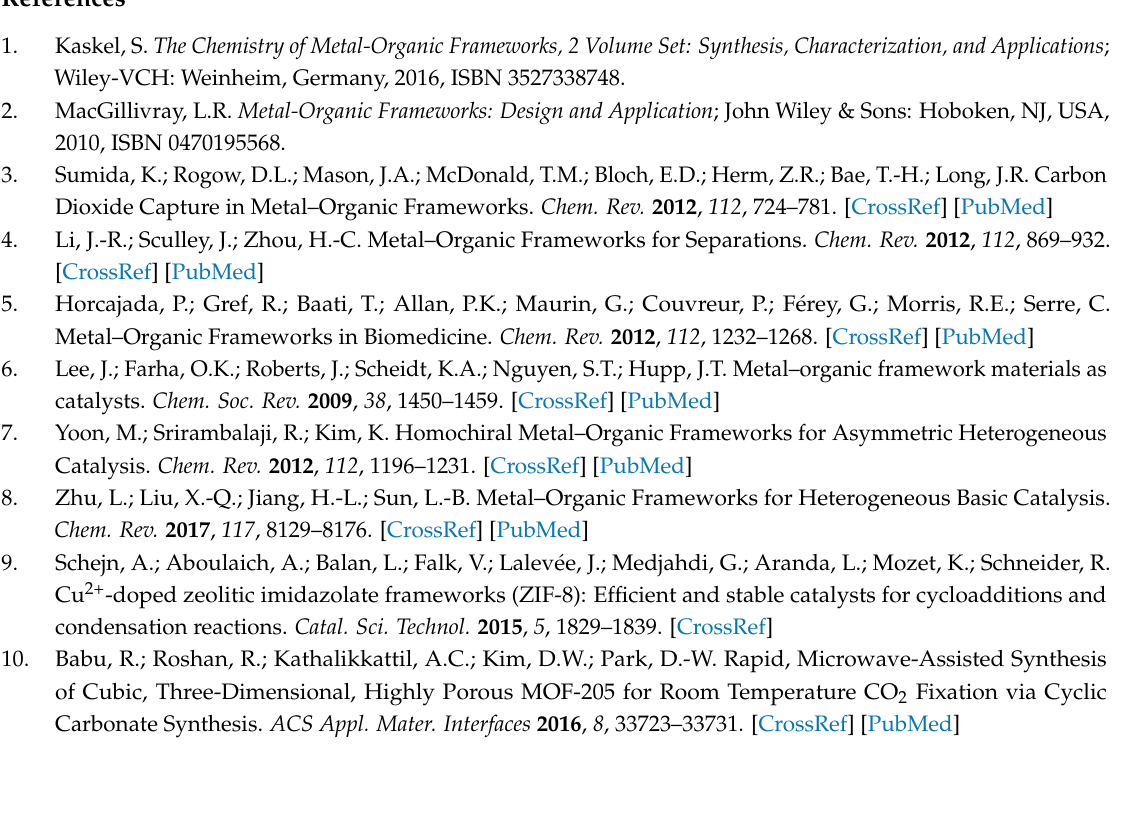
Figure S1: 1 H NMR of DMOF(Zn) after acid digestion, Figure S2: 1 H NMR of DMOF(Zn)-NH 2 after acid digestion, Figure S3: 1 H NMR of DMOF(Zn)-OH after acid digestion, Figure S4: 1 H NMR of DMOF(Zn)-1,4-NDC after acid digestion, Figure S5: 1 H NMR of DMOF(Zn)-1,5-NDC after acid digestion, Figure S6: Crystal images of functionalized DMOFs, Figure S7: 1 H NMR of BMOF(Zn) after acid digestion, Figure S8: 1 H NMR of BMOF(Zn)-NH 2 after acid digestion, Figure S9: 1 H NMR of BMOF(Zn)-OH after acid digestion, Figure S10: 1 H NMR of BMOF(Zn)-1,4-NDC after acid digestion, Figure S11: 1 H NMR of BMOF(Zn)-2,6-NDC after acid digestion, Figure S12: SEM image of functionalized BMOF(Zn)s, Figure S13: Structure of BMOF(Zn)-OH ( a ) top view ( b ) SBU-focused structure, Figure S14: N 2 full isotherm (77 K) for BMOF(Zn)-OH, Figure S15: Thermogravimetric analysis of BMOF(Zn)-OH, Figure S16: PXRD patters of BMOF(Zn)-NH 2 before and after reaction, Table S1: Crystallographic data and parameters for BMOF(Zn)-OH, Table S2: Selected bond lengths (Å) and angles (deg) for BMOF(Zn)-OH, Table S3: Reported BET value of DMOF and BMOF series, Table S4: Recycle test results from BMOF(Zn)-NH 2 catalyzed CO 2 cycloaddition with PO, Appendix I: 1 H and 13 C NMR of the obtained